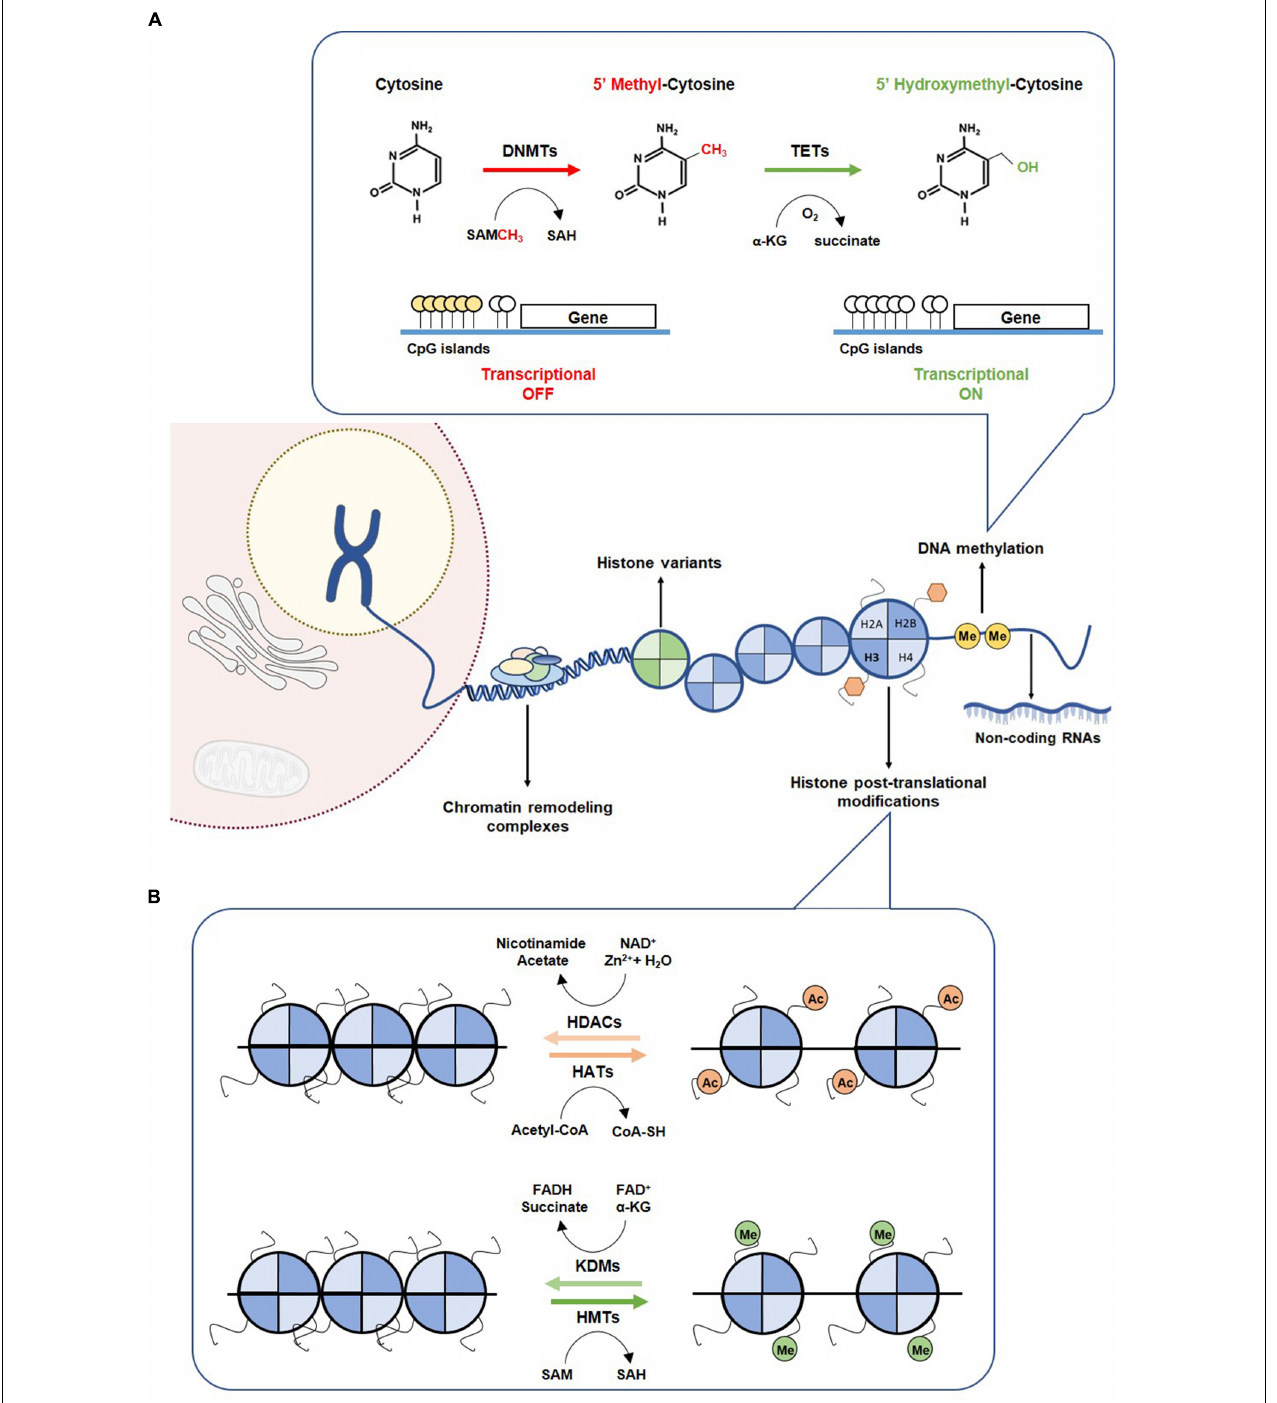
FIGURE 1 | Epigenetic mechanism. (A) DNA methylation mechanism. Methylation of cytosine to 5-methylcytosine is catalyzed by DNMTs, through the methyl donor SAM, which is converted to SAH. Hypermethylation of CpG islands of promoter regions leading to transcriptional gene repression. Hydroxylation of 5mC to 5hmC by TETs promotes a transcriptional gene activation. (B) Histone modifications. Covalent modification on histones control the accessibility of DNA to transcription factors. The writers HATs and HMTs sign acetylated and methylated marks using as co-factors the acetyl-CoA and SAM, respectively. Acetylated and methylated markers can be removed by erasers, such as HDACs and KDMs, using as co-factor Zn2+ and NAD + , respectively. DNMTs, DNA methyltransferases; HATs, histone acetyltransferases; HDACs, histone deacetylases; HMTs, histone methyltransferases; KDMs, histone demethylases; SAH, S-adenosylhomocysteine; SAM, S-adenosylmethionine; TETs, Ten-eleven translocation